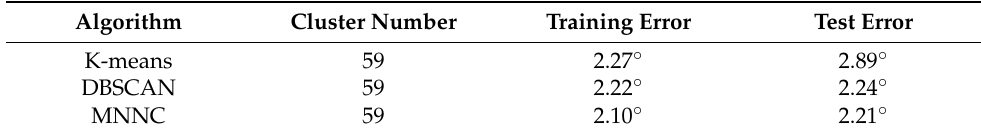
Table 3. Test results of RBFNN based on different clustering algorithms. Algorithm Cluster